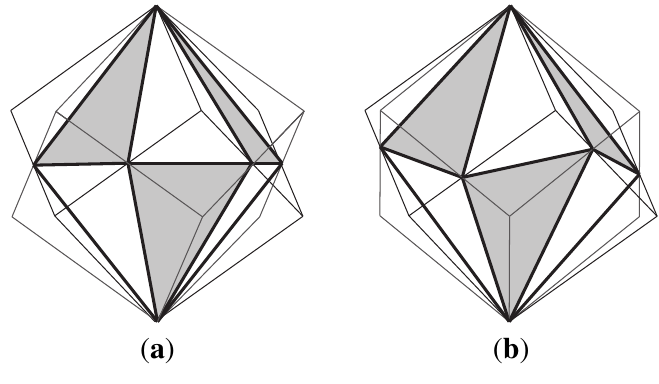
Figure 6. Double imaginary cubes obtained as the intersection of two cubes. One cube is obtained by rotating the other one by ( a ): 60 degrees, ( b ): 42